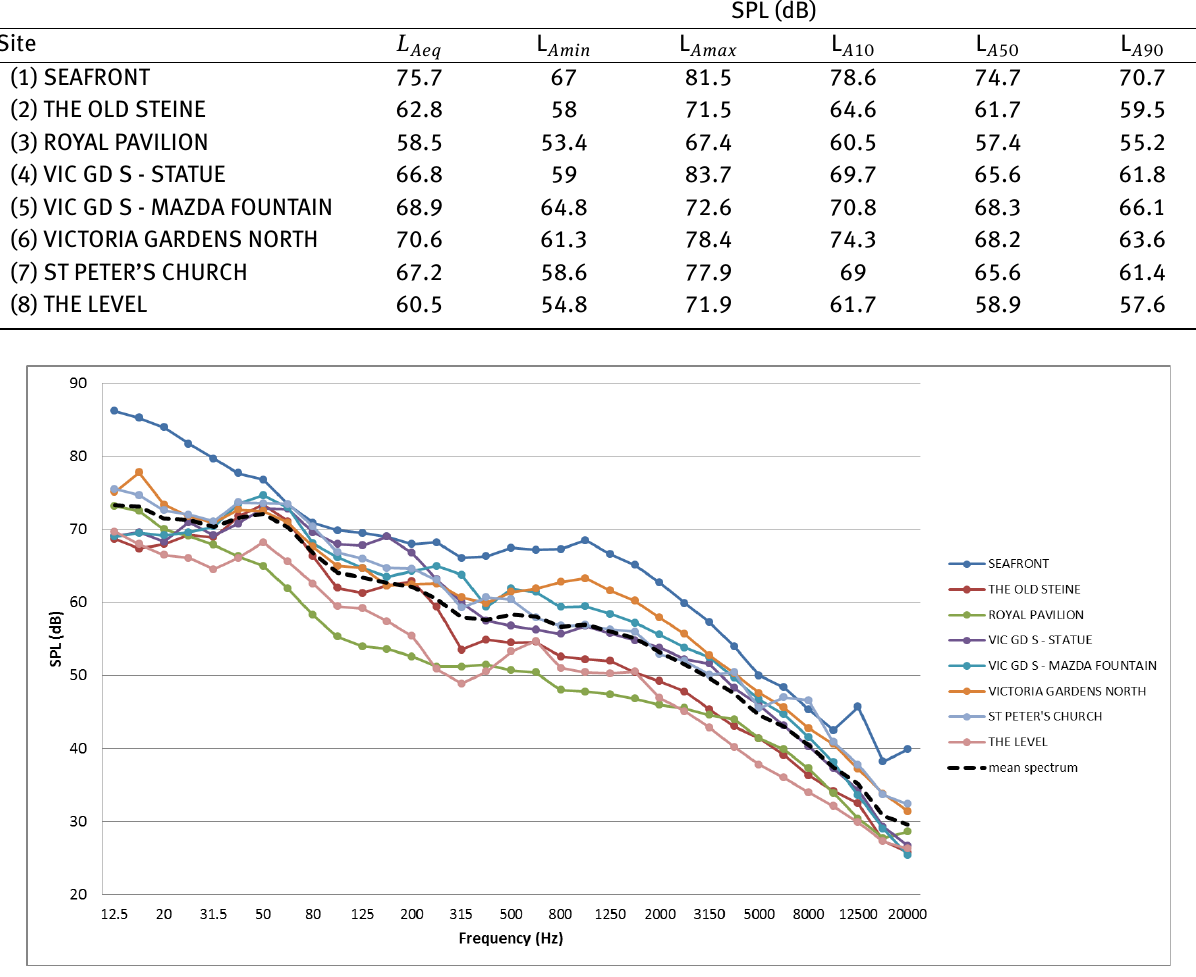
Figure 3: Frequency spectra for the eight selected locations and mean spectrum (average of left and right channel)